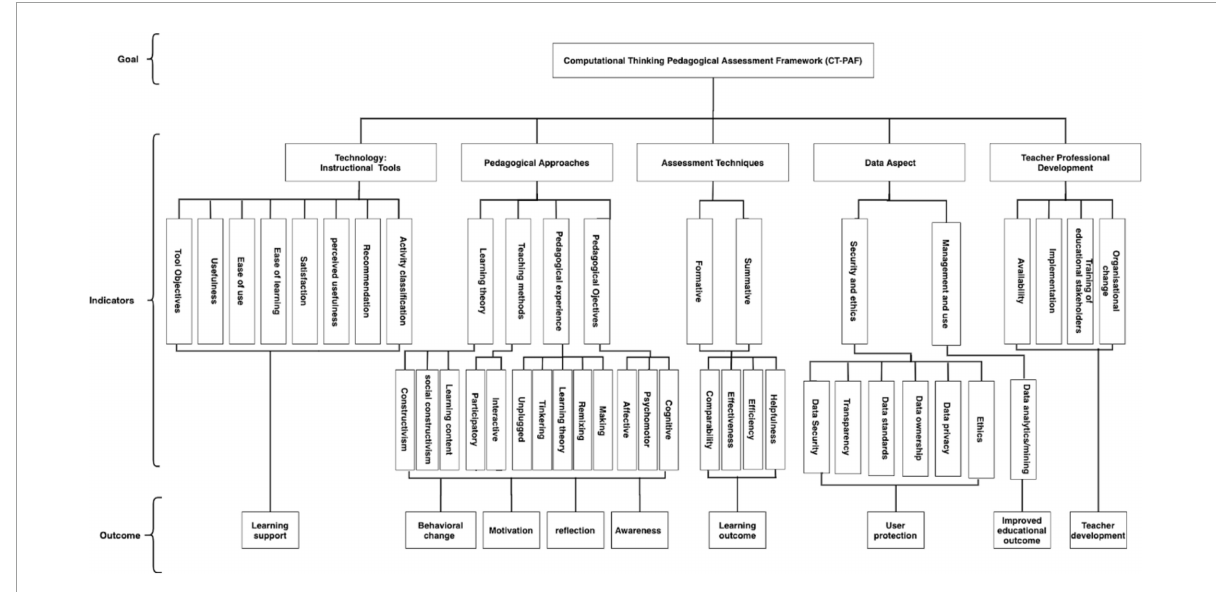
FIGURE3 Computational thinking pedagogical assessment framework